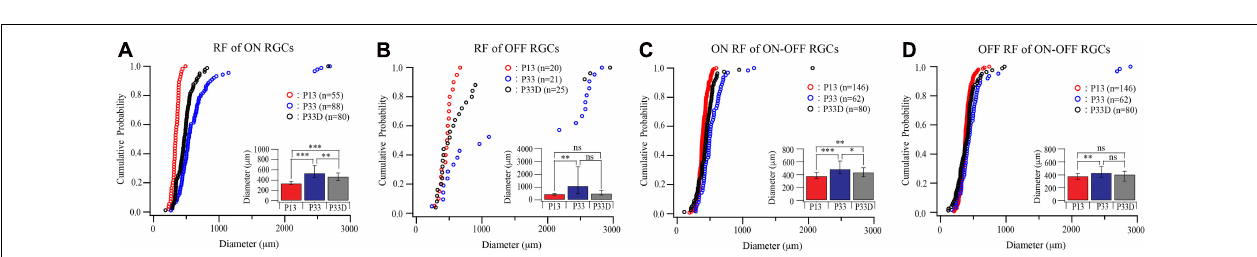
FIGURE 4 | Visual deprivation retards the developmental enlargement of dendritic fields of RGCs. (A–D) Cumulative distribution curves and median diameters of dendritic fields of P12 and P33 mice raised in cyclic light–dark condition and P33 mice raised in constant darkness (P33D) from birth for ON, OFF, and ON–OFF RGCs, respectively. Inset: median diameters of dendritic fields. Error bars in the bar graphs indicate IQR. *0.05 > p > 0.01; **0.01 > p > 0.001; ***0.001 > p; ns, not significant.